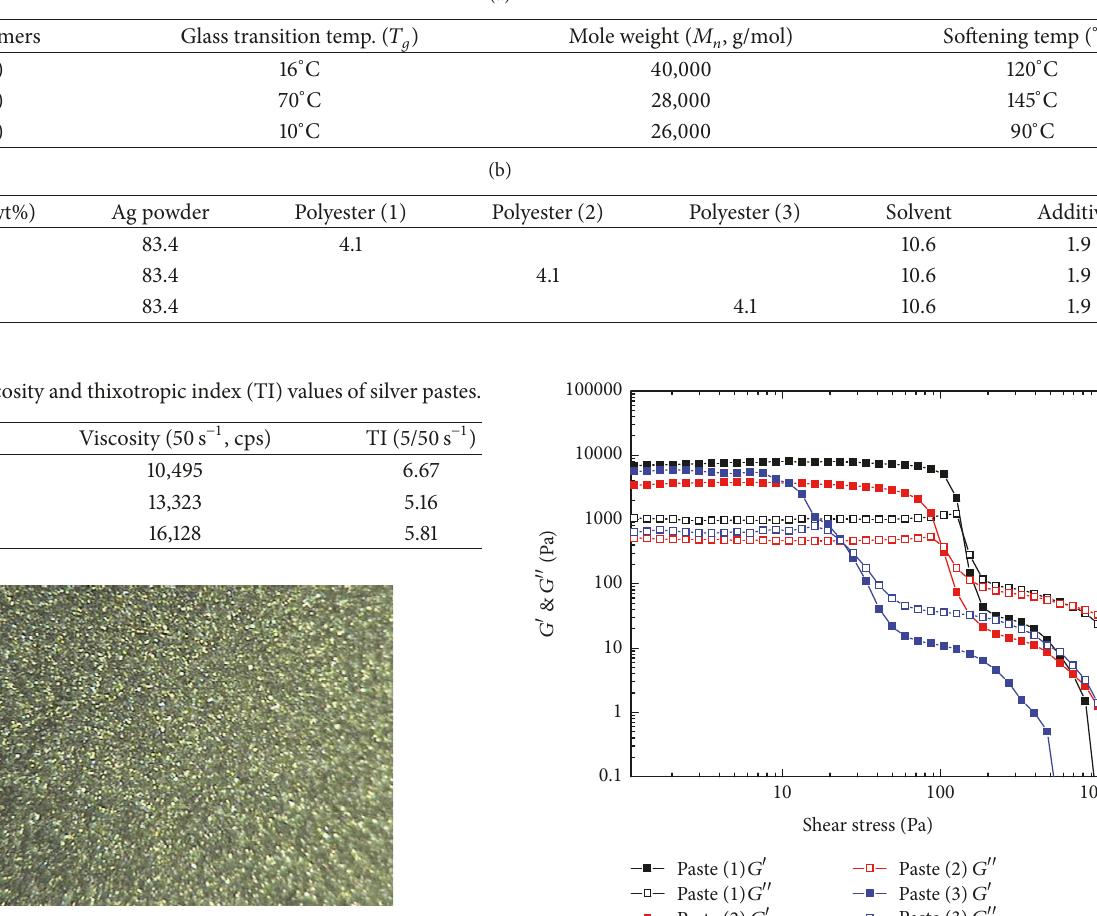
Table 1: Physical property of binder polymers and formulation of silver pastes.